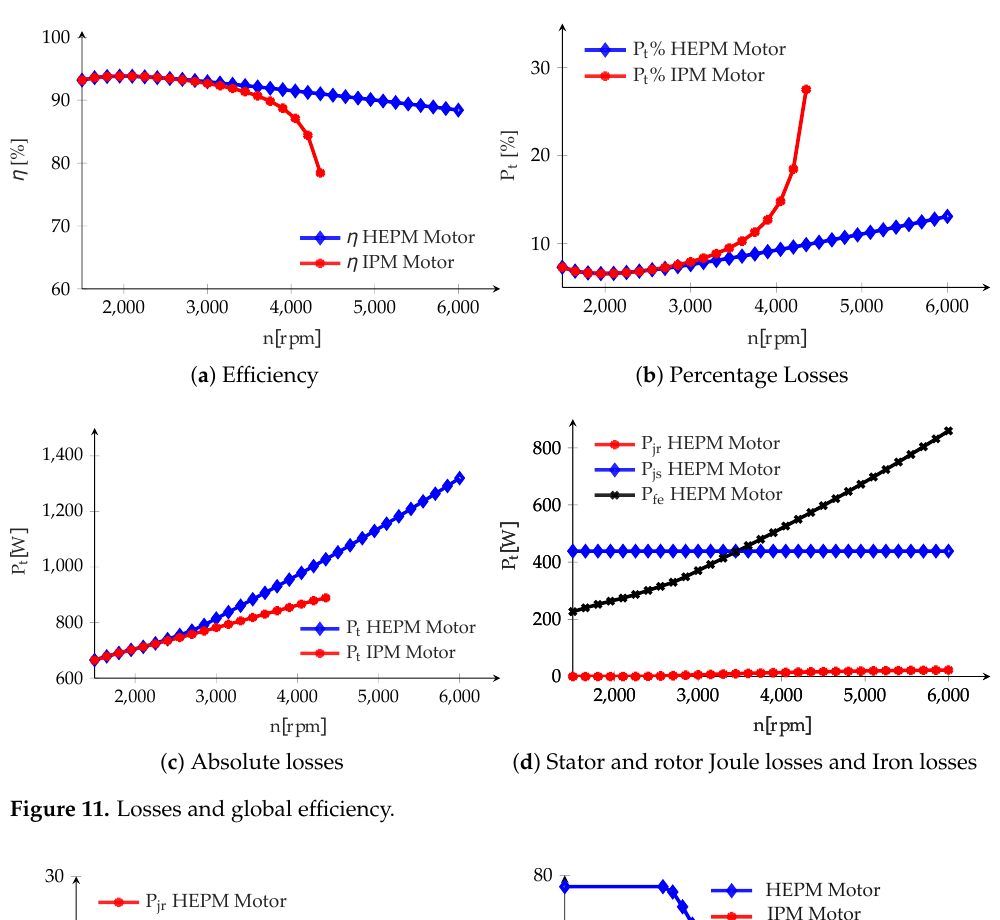
Figure 11. Losses and global efficiency.